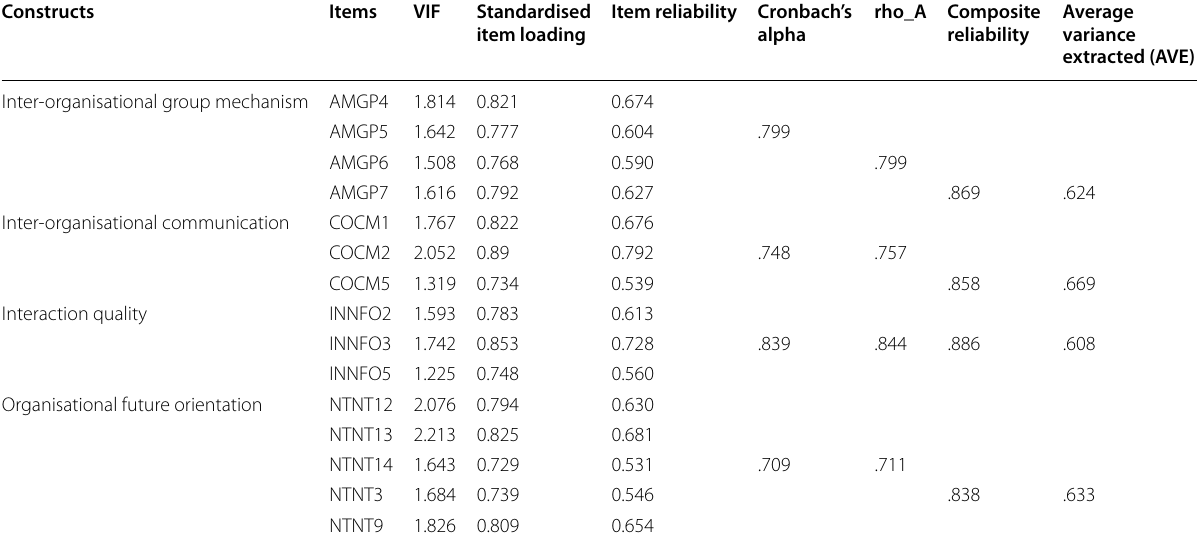
Table 3 Measurement model results